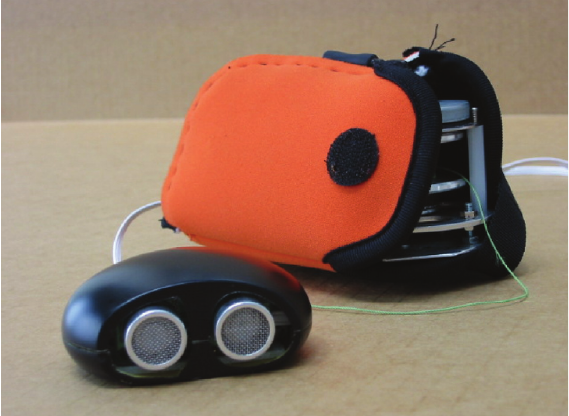
Figure 6: Second developed prototype of